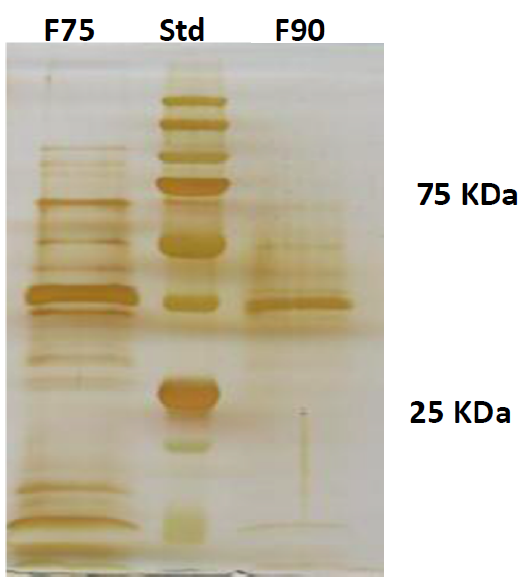
Figure 2. SDS-PAGE of F75AS (left line) and F90AS (right line) protein fractions. Std is the protein marker (middle line). The molecular range of std is from 11 to 245 kDa. marker (middle line). The molecular range of std is from 11 to 245 kDa.